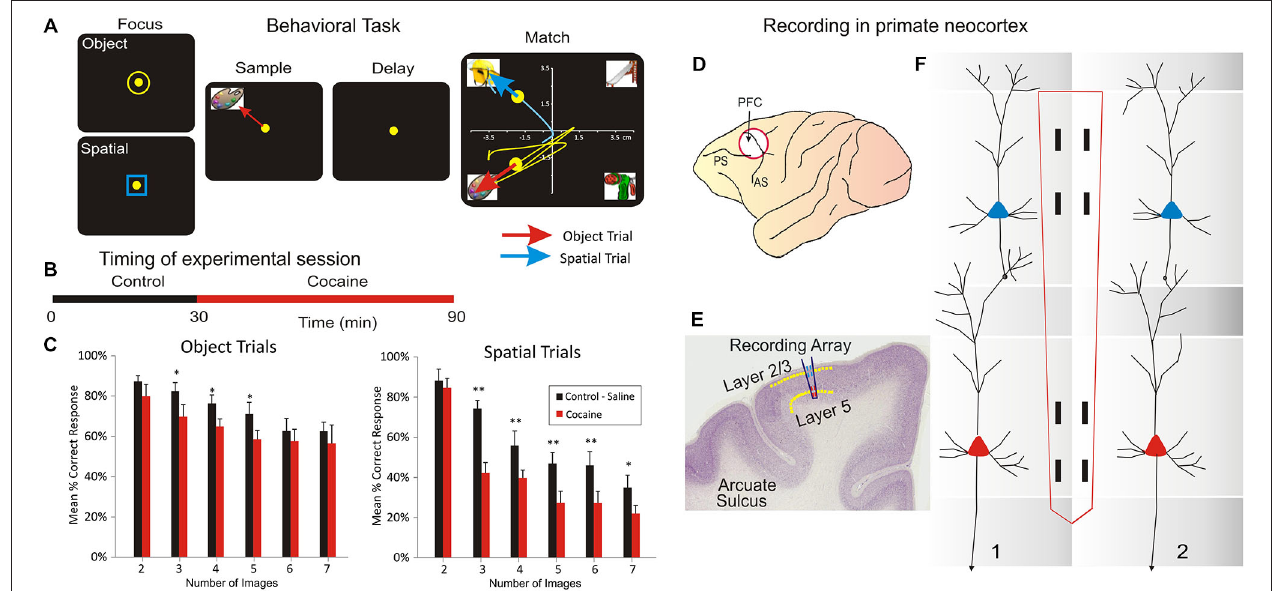
cursor into a non-match “distracter” image for ≥ 0.5 s constituted an error and caused the trial to terminate and the screen to blank without reward delivery. The Inter-trial interval (ITI) was 10.0 s for all trials. (B) DMS session timeline shown for combined Control (saline) and Drug (cocaine) administration phases of the same trial. (C) Mean percent correct performance on Spatial and Object trials averaged across all animals ( n = 4) for trials with different numbers of distracter images (1–6) in the Match phase of the DMS task. (D) NHP brain profile showing the placements of recording Multielectrode arrays (MEAs) in the Prefrontal Cortex. (E) Illustration of coronal section in NHP frontal cortex showing relative placement location of MEA probes in supra-granular layer 2/3 and infra-granular layer 5 shown in (F) . (F) Dimensionally relevant illustration of the conformal MEA positioned for simultaneous recording from neurons in both layers via adjacent minicolumns (1 and 2), consisting of a “pair” of cells recorded with one in L2/3 and the other in L5 PFC for each minicolumn. Reprinted with permission from Opris et al.